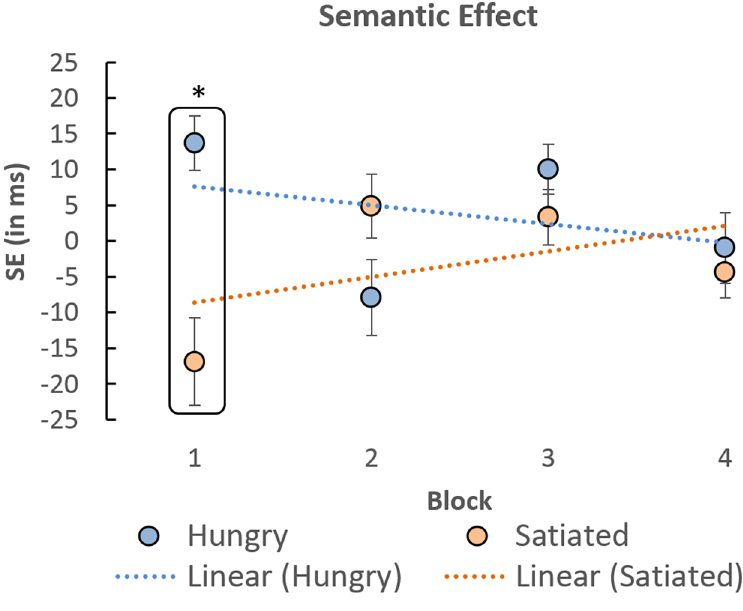
Fig 3. Effect induced by food-related deviant words relative to that induced by control deviant words, as a function of block and group. Dashedlines represent the linear trend exhibitedby each groups across blocks. Error bars represent one standard error of the mean. * p <